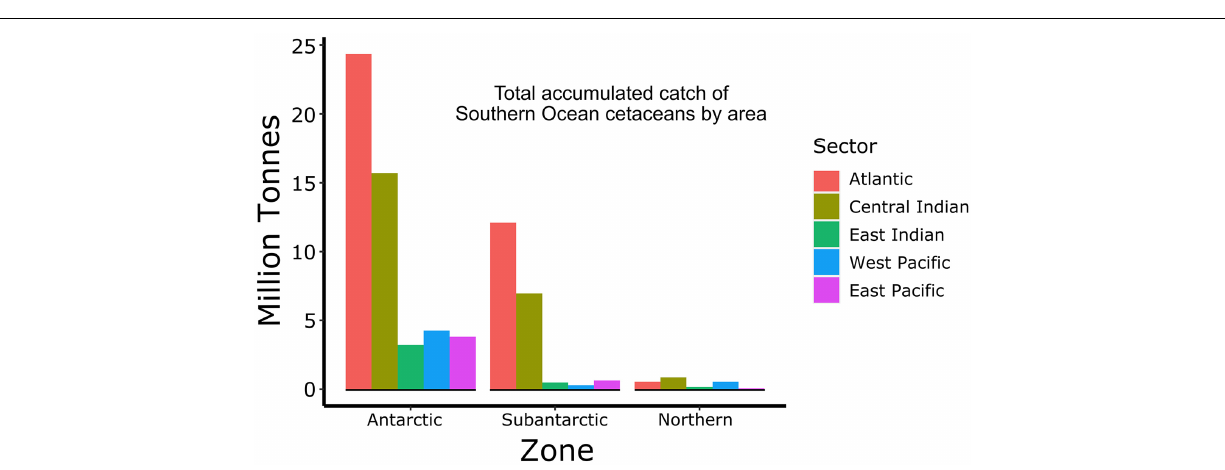
‘incidental mortality’ which is the unintentional capture or death of species not targeted by the